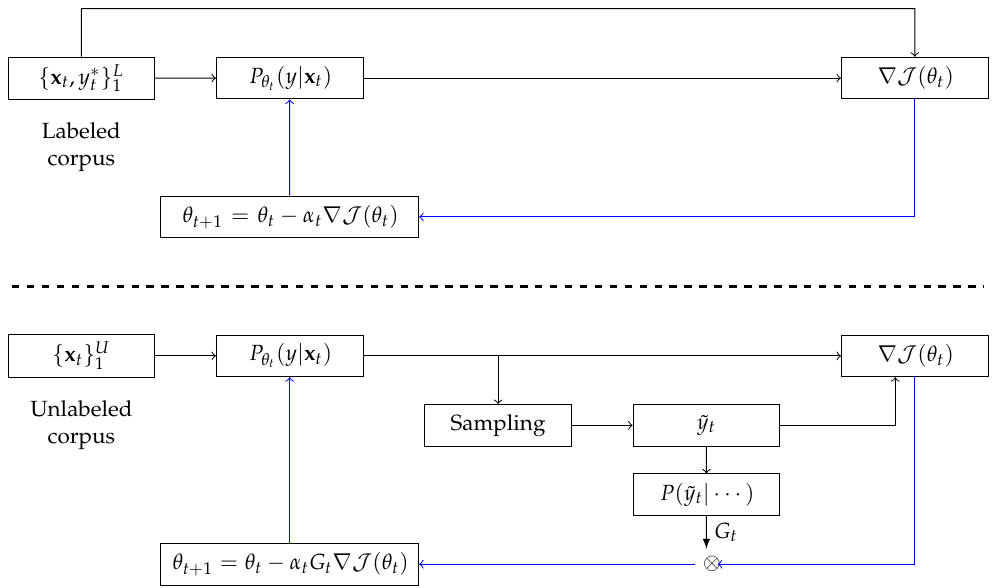
Figure 3. Block diagram of the proposed semi-supervised training